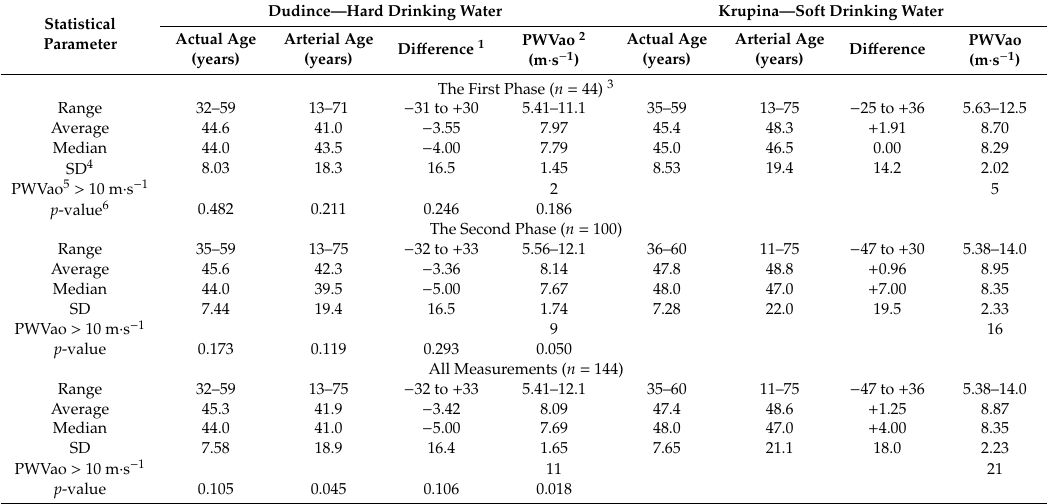
Table 4. Common statistical parameters of the measured characteristics of respondents in the 1 st , 2 nd and both research